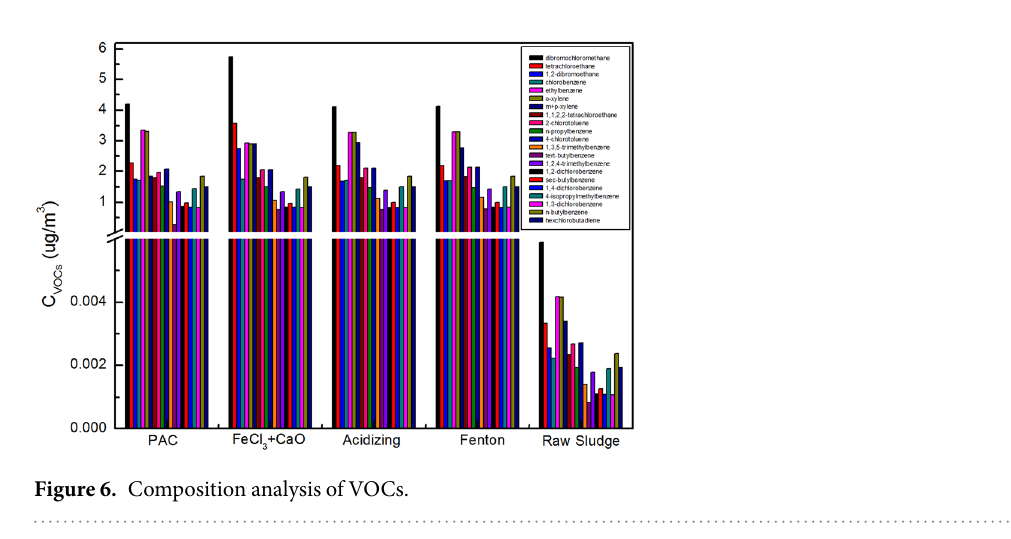
Figure 5. Effect of chemical conditioning on VOCs emissions divided into three main groups compositions.